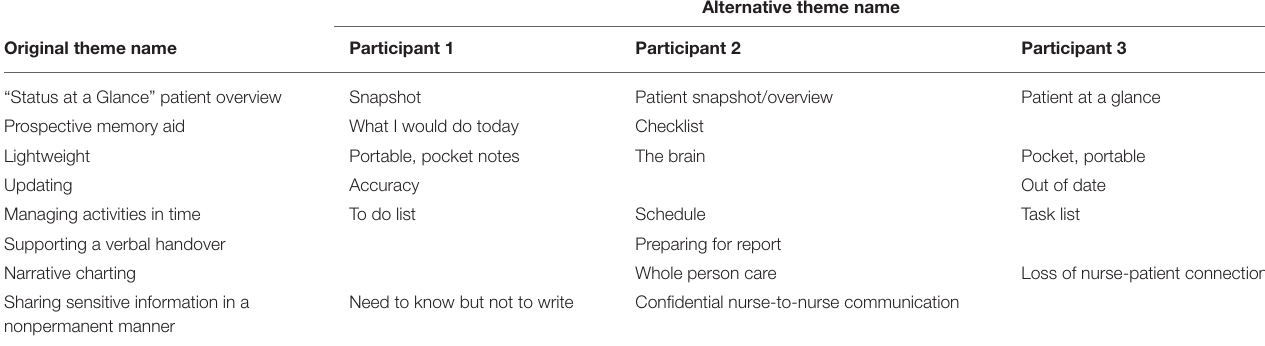
TABLE 3 | Alternative names for eight emergent themes.